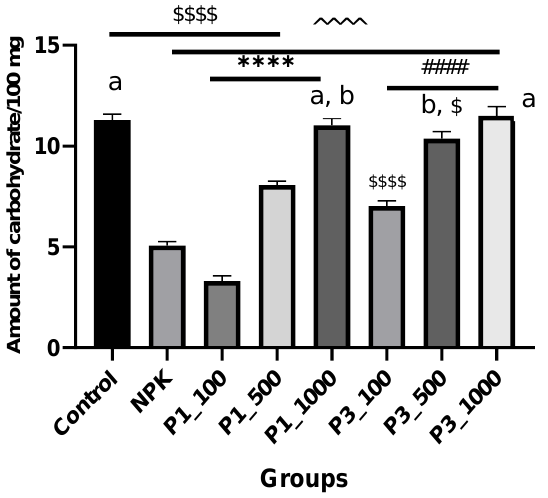
Figure 6. Total soluble carbohydrates in different nHAPs-treated plants. Results are expressed as mean ± SE, $ (dollar sign) significant difference with negative control at p < 0.0001, # (number sign) statistically compared P3 groups with the P3_100. ˆ (circumflex accent) statistically compared with NPK. Different letters refer to a statistically significant difference between groups at p ≤ 0.001, while the same letters refer to a non-significant (ns) difference between groups at p ≤ 0.05, using one-way ANOVA followed by Tukey’s test. **** indicates p ≤ 0.0001, (that was applied to the other signs). P1 = nHAP_PPE, P3 = nHAP_CE.